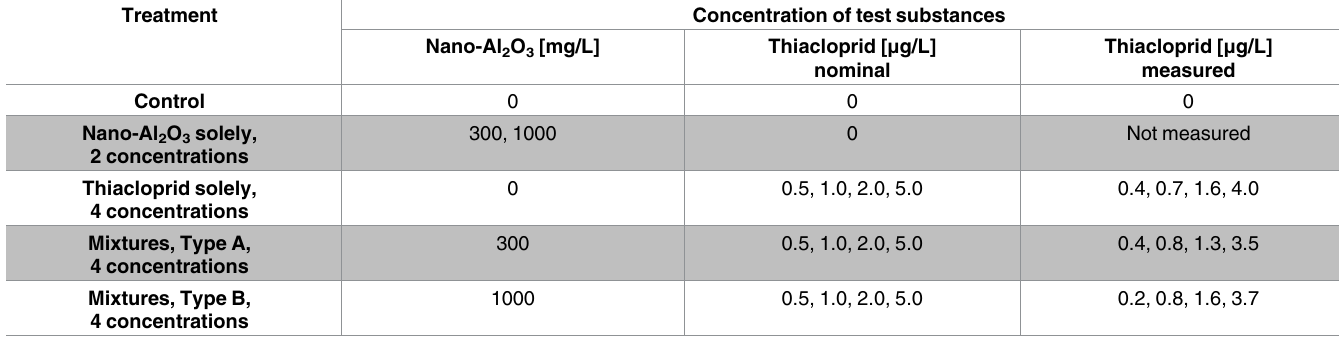
Table 1. Tested substances and